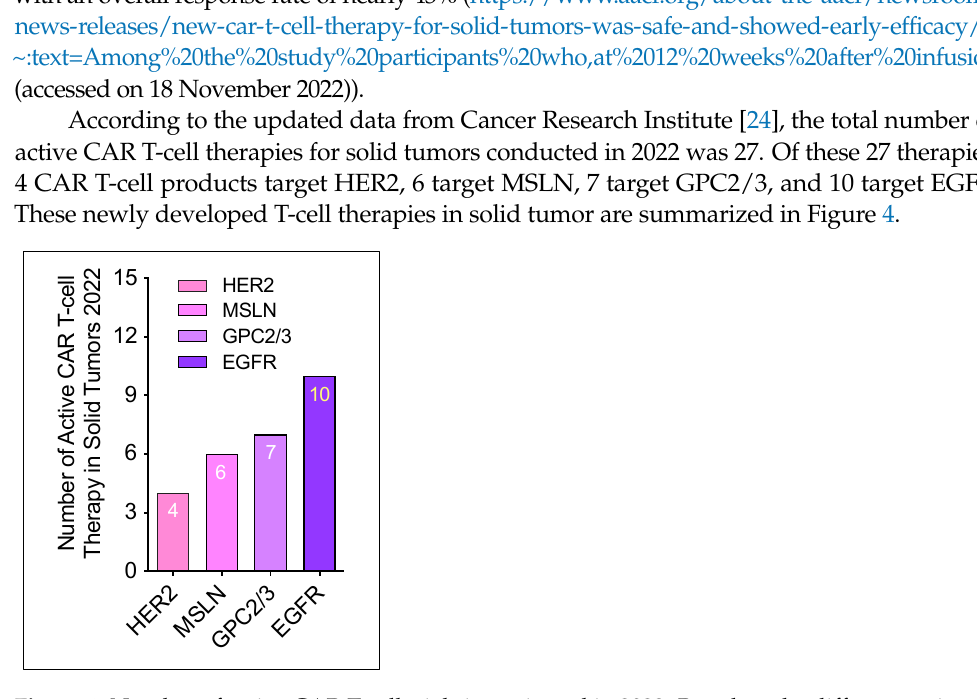
Table 2. Most targeted antigens in clinical trials of CAR T-cell therapy in solid tumors . Antigen